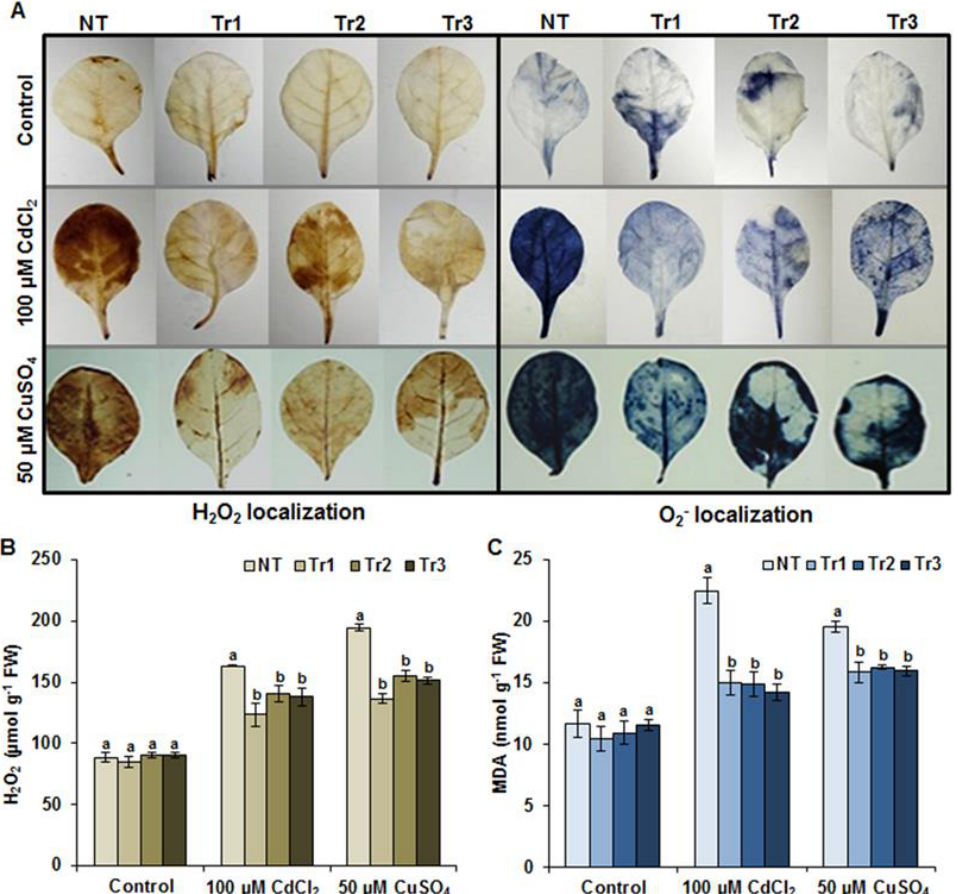
Figure 6. Biochemical analysis of the NT and transgenic lines overexpressing the LmTrxh2 gene under different heavy metal stress conditions. ( A ) The revelation of O 2 − localization by NBT and H 2 O 2 localization by DAB staining. MDA ( B ) and H 2 O 2 ( C ) contents in the NT and transgenic lines that were exposed to MS liquid medium supplemented with or without 100 µmM Cd or 50 µmM Cu. The means denoted by the same letter did not differ significantly at p < 0.05.